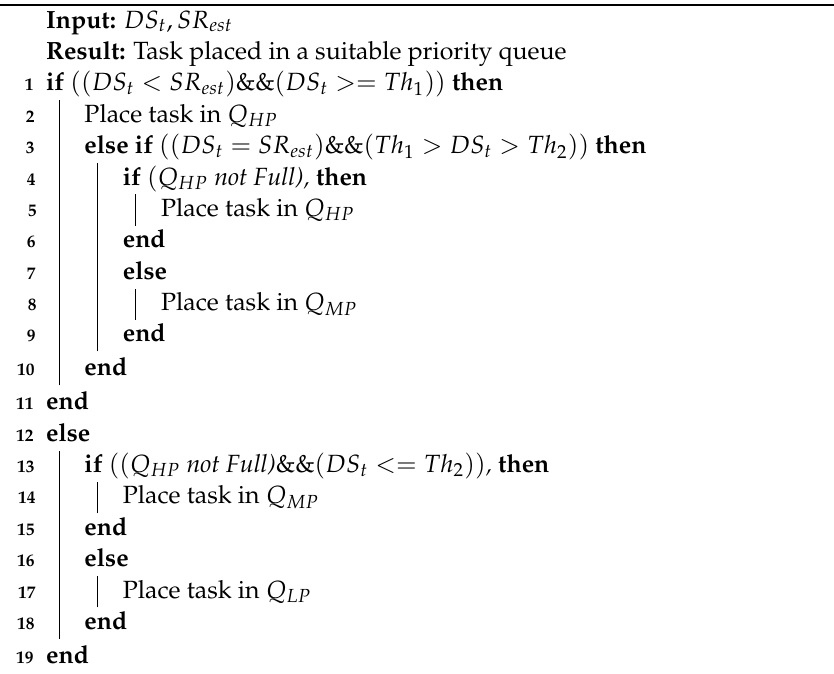
Algorithm 1: Delay sensitivity-based priority scheduling (DSPS)